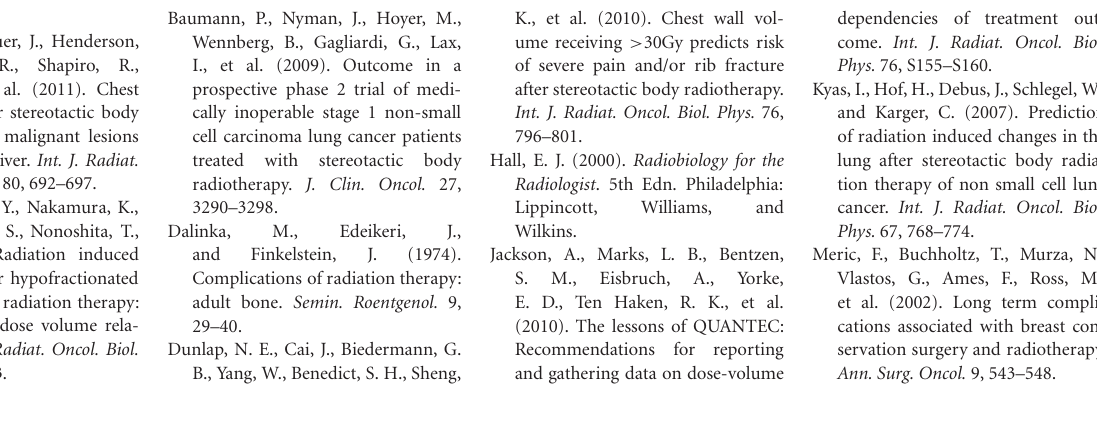
population that arc treatment will increase dose to pulmonary parenchyma in patients treated with this technique. We note only one patient experienced an increase in pulmonary V20 with optimal VMAT planning relative to planning with static fields (patient 4/12% increase). It is likely VMAT technology can play an important role in hepatic radiotherapy when tumor comes in close approximation to the chest wall as well as other tumor tar- gets in multiple body locations that abut critical normal tissue